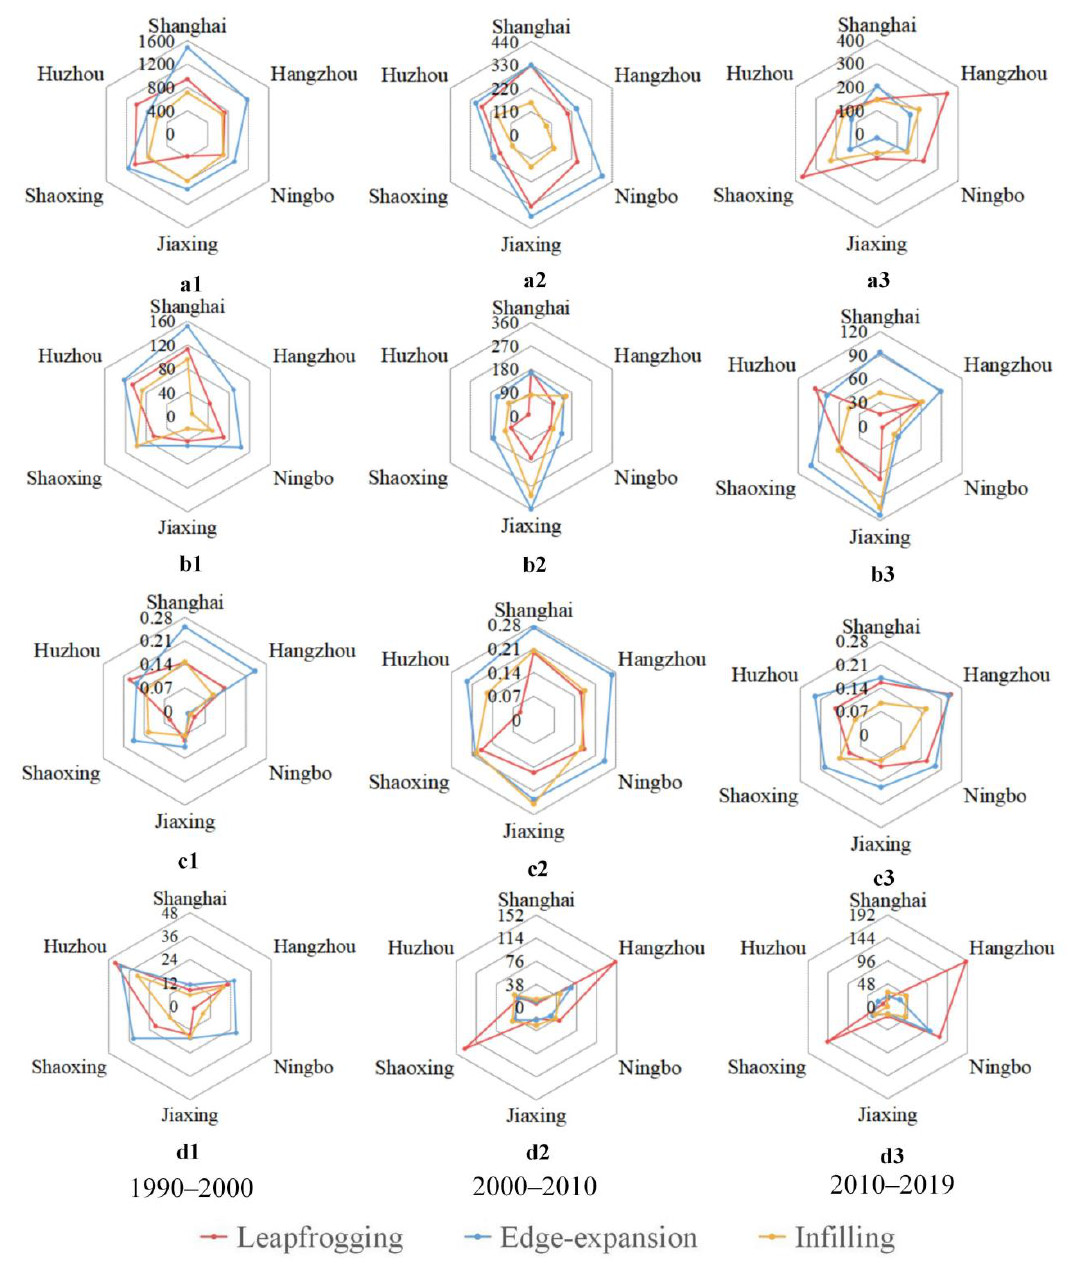
Figure 9. Impact of urban expansion forms on ESs in different cities from 1990 to 2019: ( a ) Carbon sequestration; ( b ) Food supply; ( c ) Habitat quality; ( d ) Soil retention.